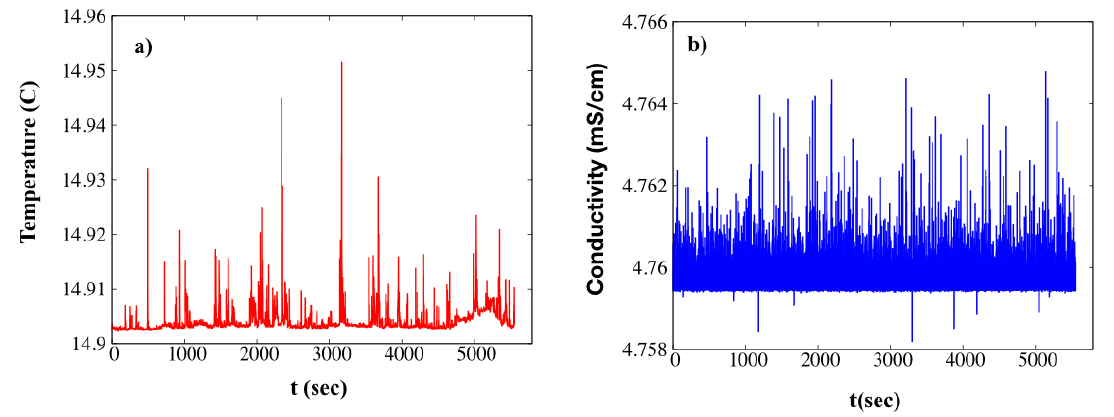
Figure 2. The time series (summer 2010) of ( a ) temperature and ( b ) conductivity. Notice that conductivity changes are very small and present a regularity; instead, temperature variations are a bit larger and possess some irregular